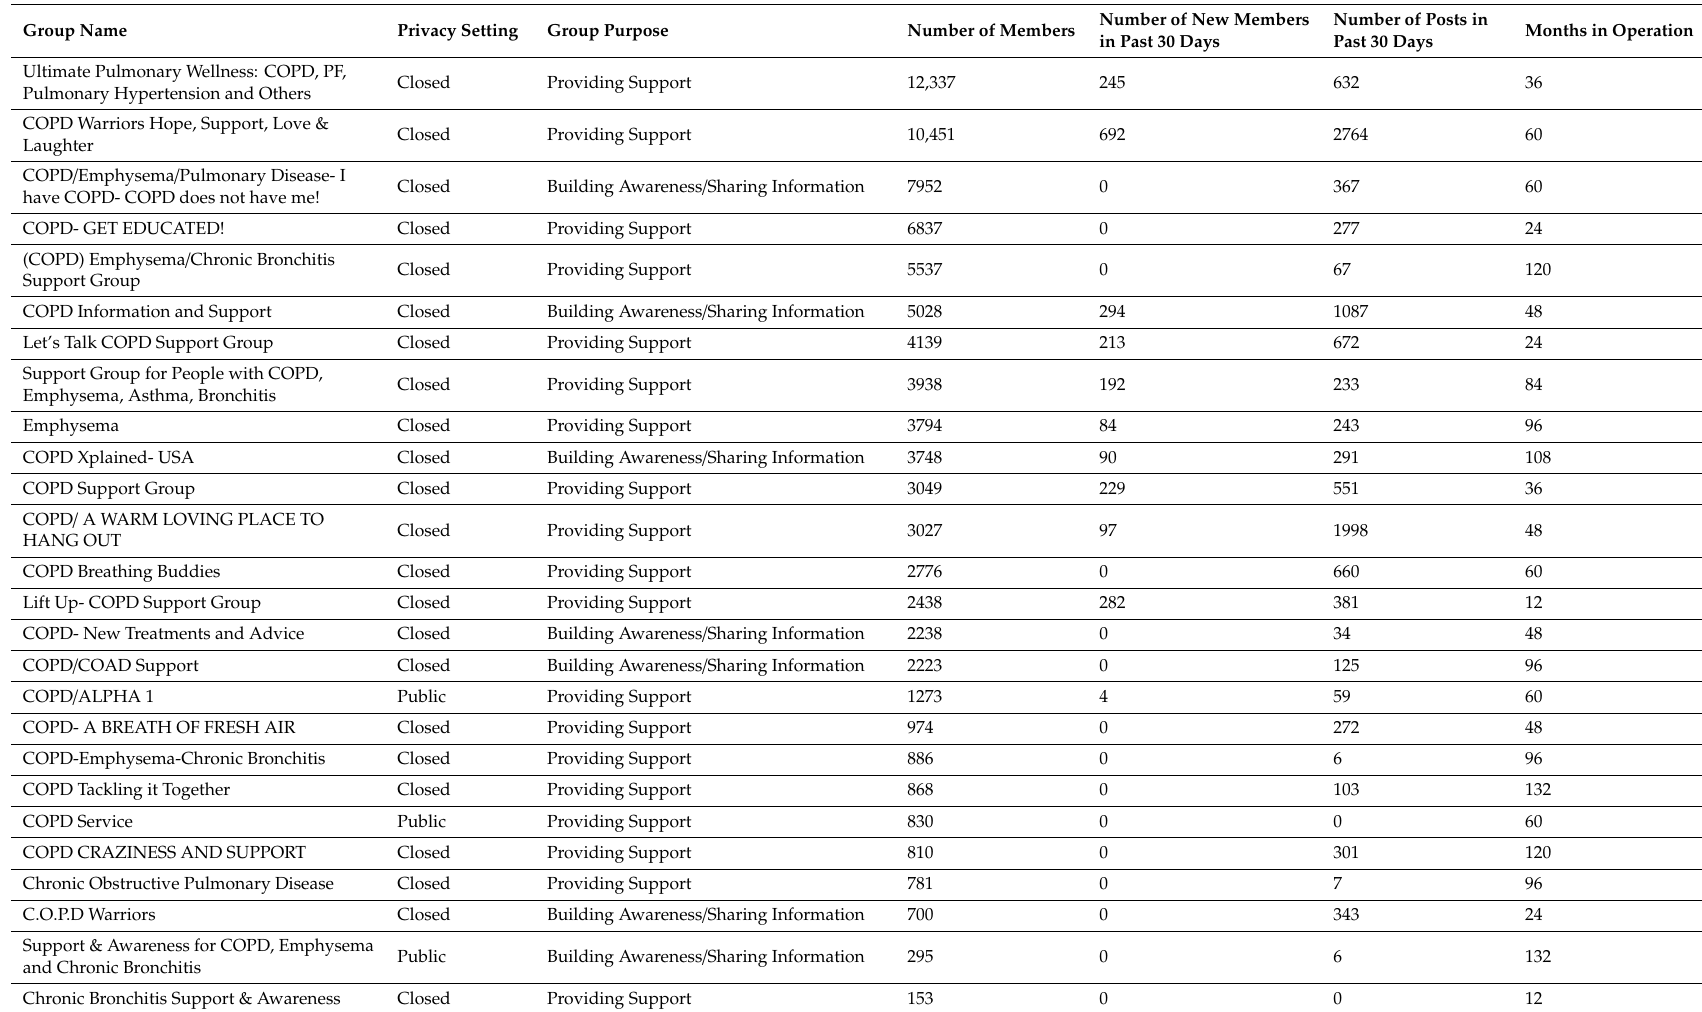
Table 3. General characteristics and membership in 26 COPD Facebook groups as of March